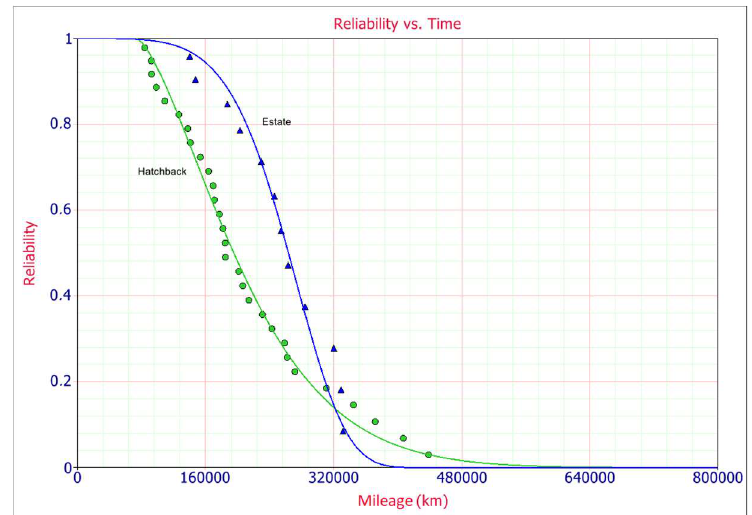
Figure 4. Comparison of 3P-Weibull reliability.